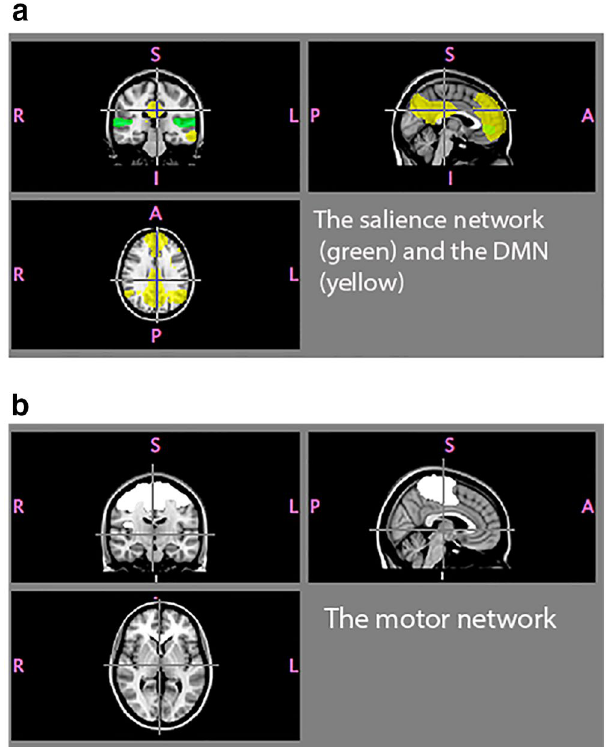
Figure 1. The networks investigated. ( a ) Illustration of the DMN (yellow) and salience (green) networks superimposed on the MNI standard brain. ( b ) The motor network is indicated in